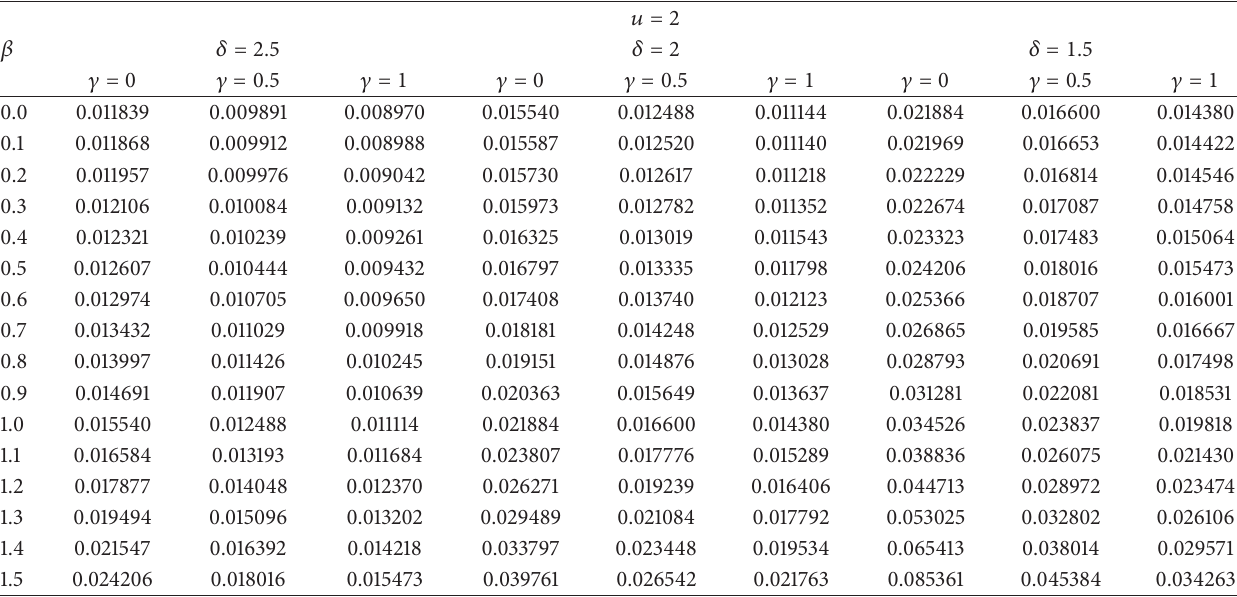
Table 1: Exact values of 𝜙(𝑢) under different stochastic interest models.